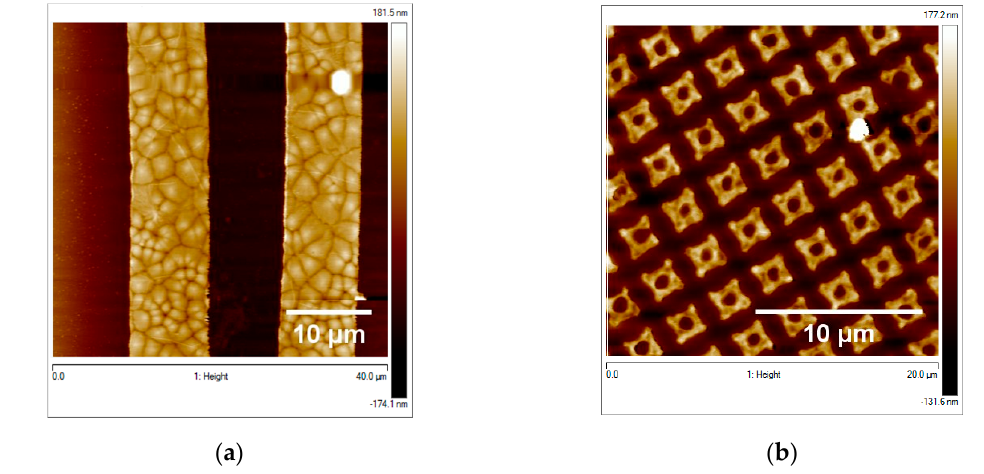
Figure 9. ( a ) 40 × 40 µ m AFM micrograph of the 10 µ m micro lines of PVDF; ( b ) 20 µ m AFM micrograph